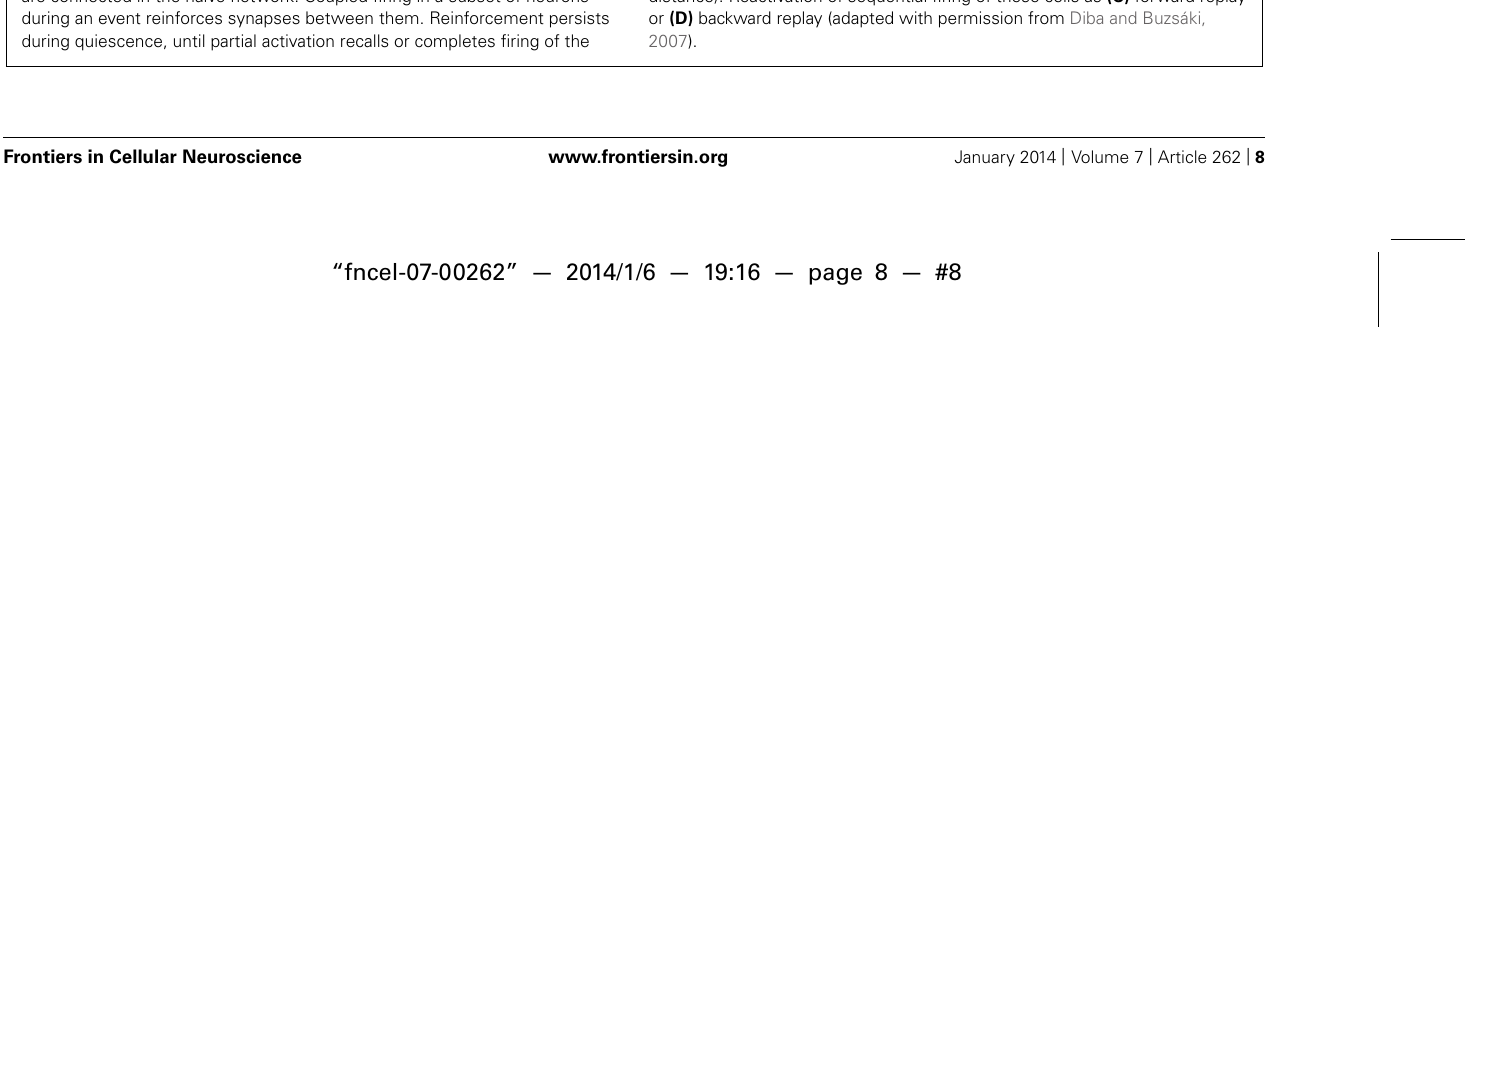
FIGURE 5 | Recurrent excitatory networks. (A) Possible schema of connectivity and operations in a recurrent neuronal network. Some neurons are connected in the naïve network. Coupled firing in a subset of neurons during an event reinforces synapses between them. Reinforcement persists during quiescence, until partial activation recalls or completes firing of the